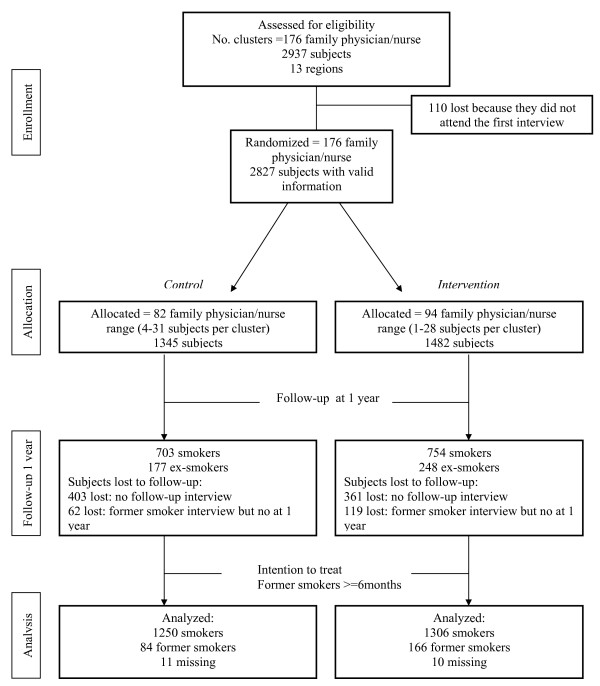
Flowchart of the ISTAPS study.